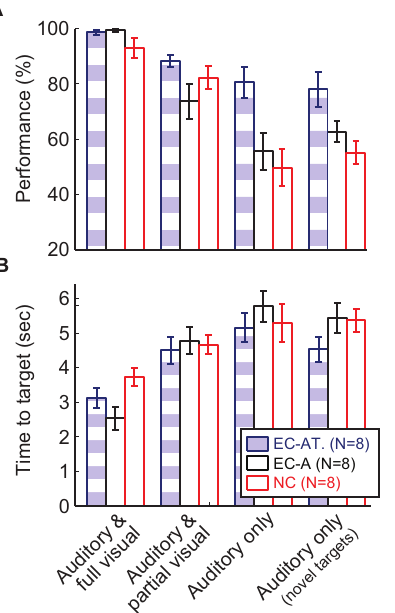
Figure 3. Participant performance in terms of percent of performance (targets reached; A) and time to target (reaction time; B) are shown for established categories with auditory and text cues (blue and white striped; EC–AT), established categories with only auditory cues (black; EC–A), and new categories (red; NC). While the time-to-target data did not show differences between training schemes, the percent correct performance showed significant differences across training groups: the EC-AT group performance was significantly higher than the EC-A and NC groups (both p adj , 0.002). There was a trend for an interaction between session and training group, suggesting that categorical vowel perception aided participants in utilizing and generalizing auditory feedback (third and fourth sessions). Error bars show 6 1 standard error.